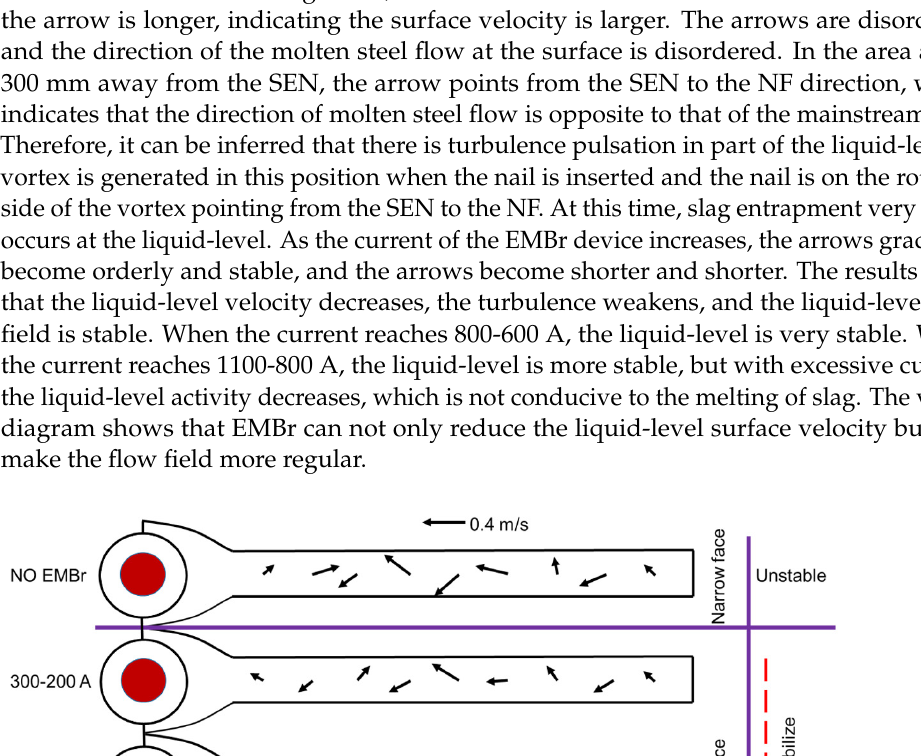
Figure 19. Funnel mold surface velocity. Figure 20 is a vector diagram of molten steel flow at the FM liquid-level. The arrow